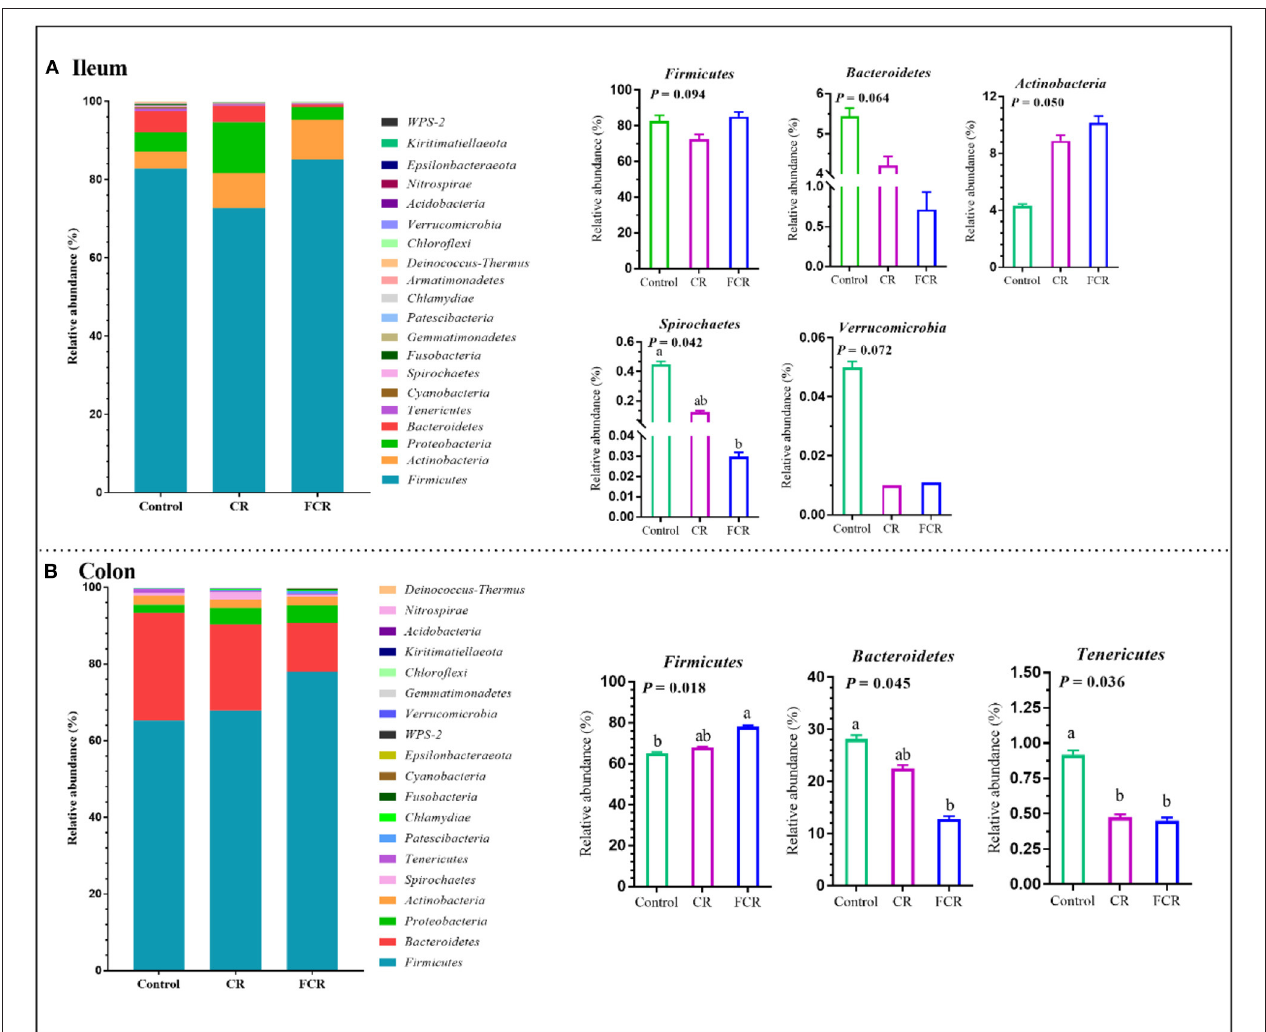
FIGURE 2 | The relative abundance of piglets’ ileal (A) and colonic (B) microbiota community and taxonomic differences at the phylum level ( n = 7–8). The data are presented as the means ± SEM, and values with different letters mean significant difference ( P <